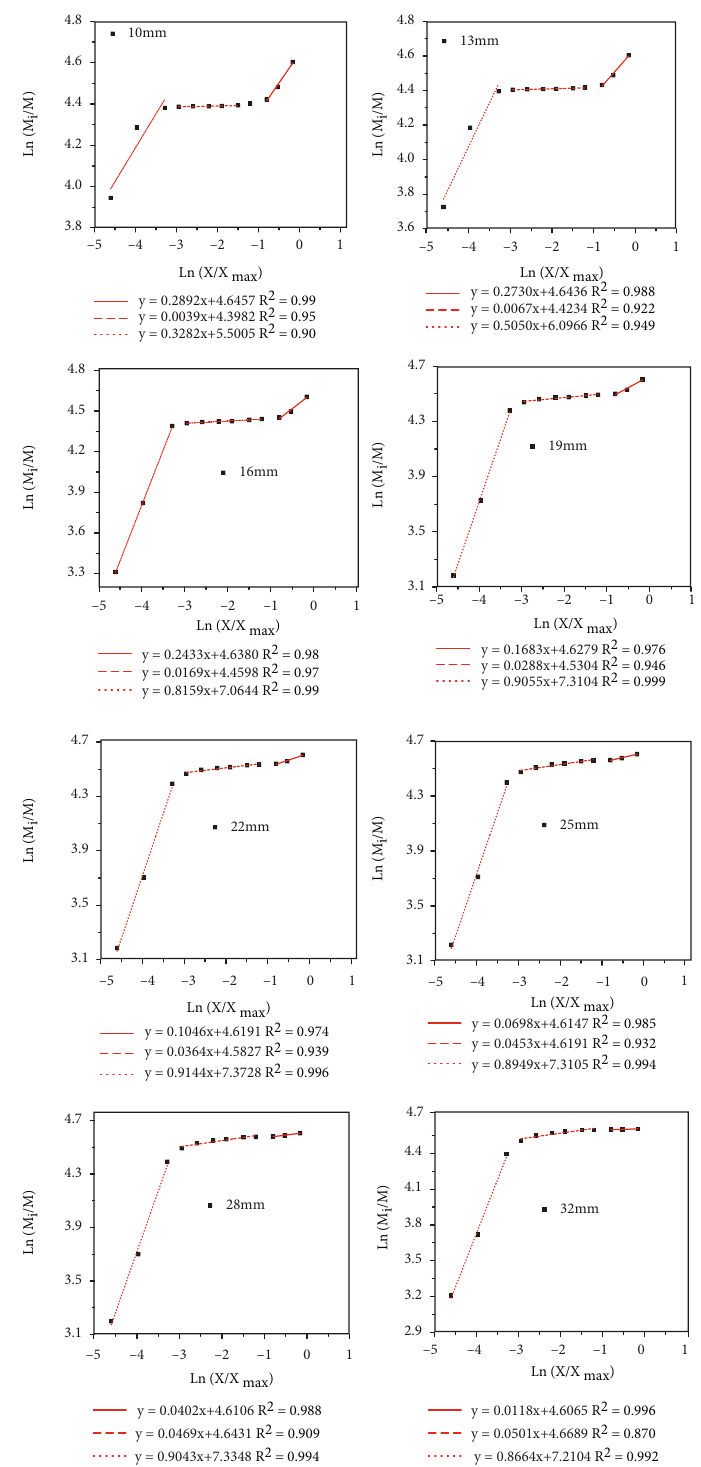
Figure 4: Multifractal analysis of magnetite grinding products by steel balls of di ff erent